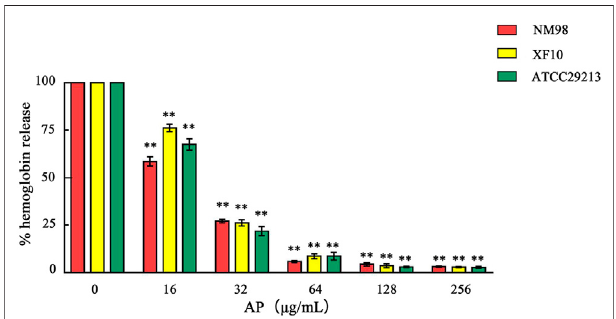
FIGURE4| EffectofAPon S.aureus hemolysis.Note:NM98,XF10,and ATCC29213 denote different S. aureus strains; ** indicates p < 0.01 compared with the AP-free culture.